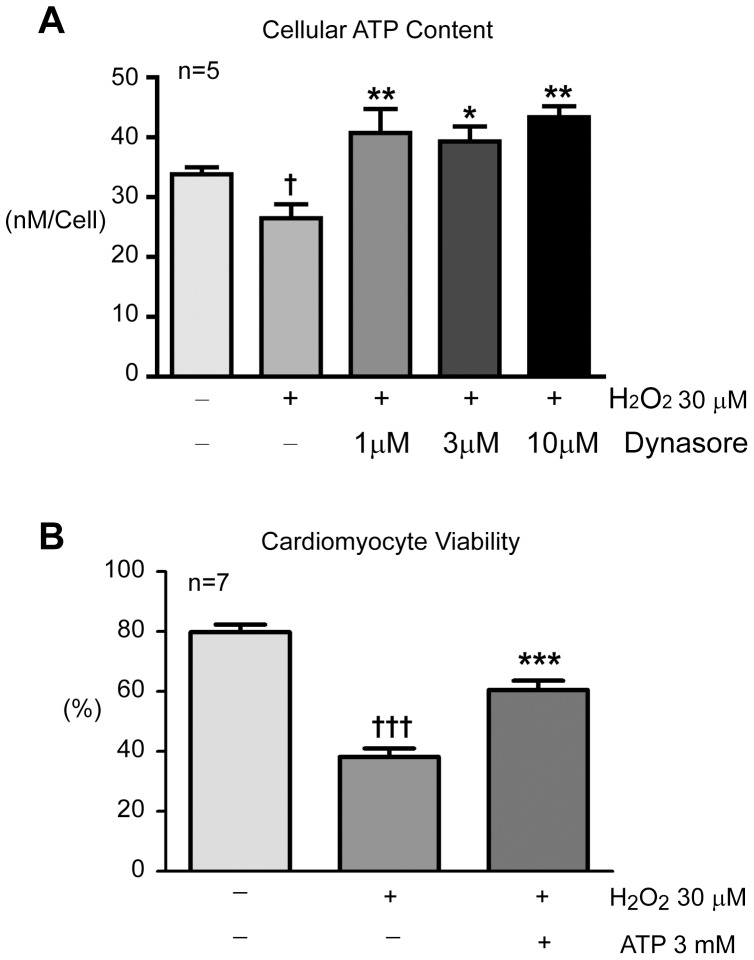
Dynasore preserves cellular ATP content in stressed cardiomyocytes.A. Dynasore preserves cardiomyocyte ATP content. Adult mouse cardiomyocytes were exposed to 30µM H2O2 for 35 min in the absence and presence of Dynasore. Cellular ATP content (total ATP normalized to amount of surviving cardiomyocytes) were calculated and compared among the different treatment groups. B. Direct supplement of ATP (3 mM in culture medium) increases cardiomyocyte survival after H2O2 exposure. (**P<0.01, ***P<0.001 when compared to H2O2 stressed cardiomyocytes without Dynasore treatment; †P<0.05, †††P<0.001 when compared to control cardiomyocytes).